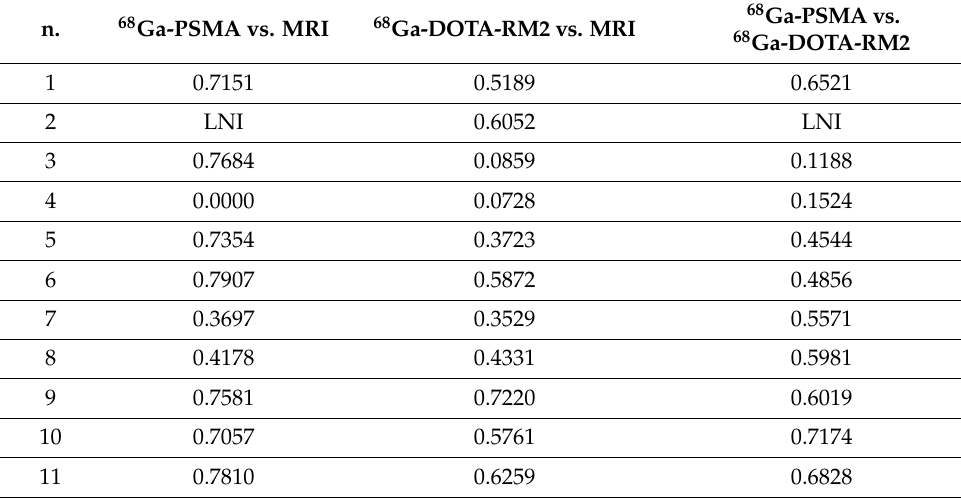
Table 6. DICE scores.